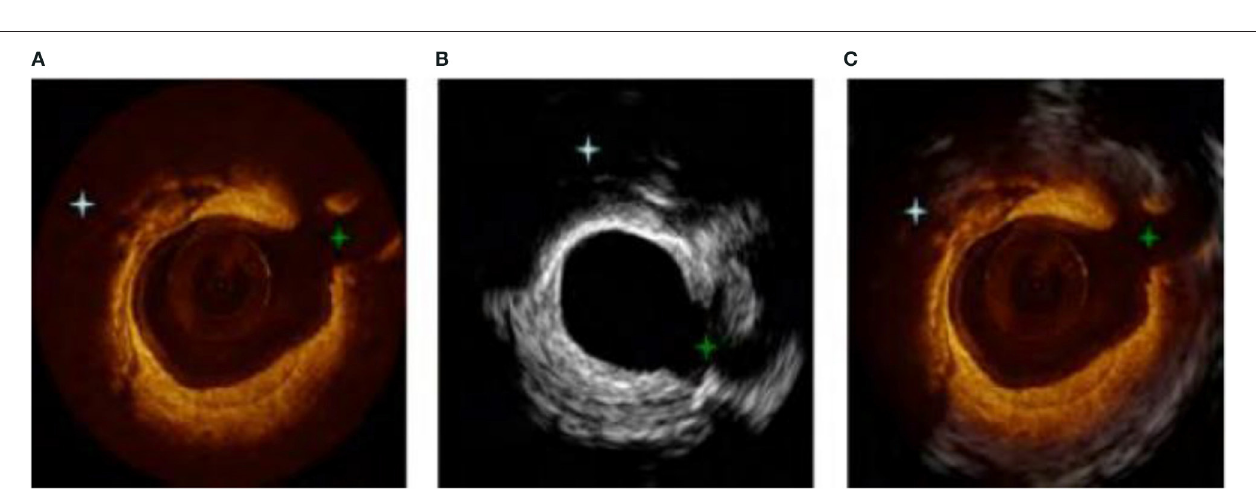
FIGURE 9 | Reconstruction results of new type of intravascular ultrasound combined with X-ray angiography.